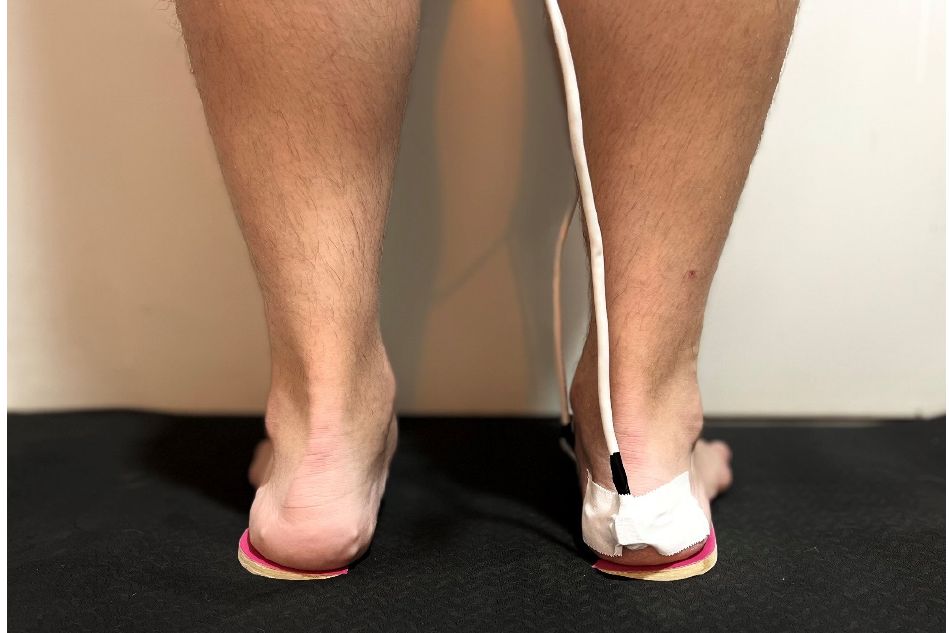
Figure 3. LWIs were placed under the calcaneus bones of both